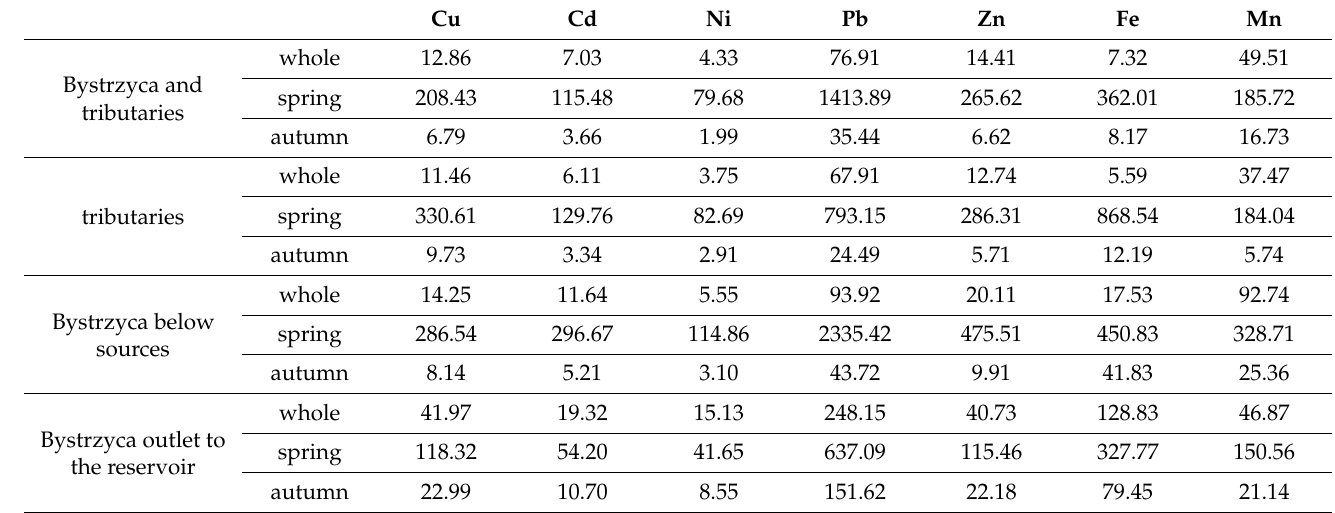
Table 13. Enrichment factor (EF) in reed canary grass from the Bystrzyca River.